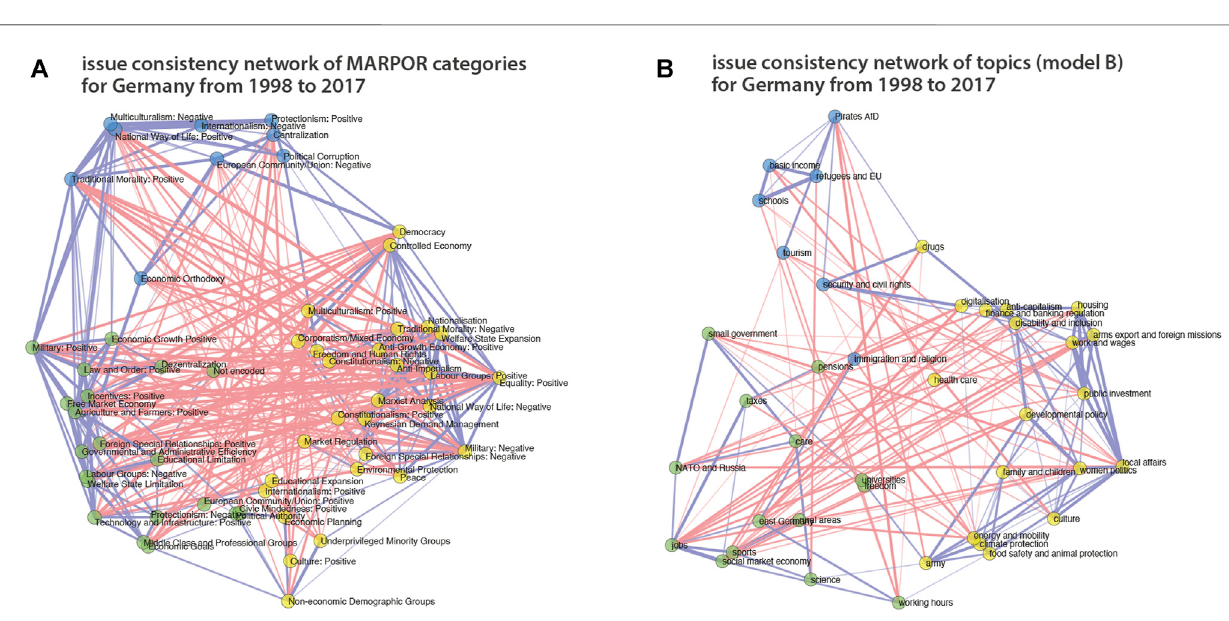
Frontiers in Big Data |